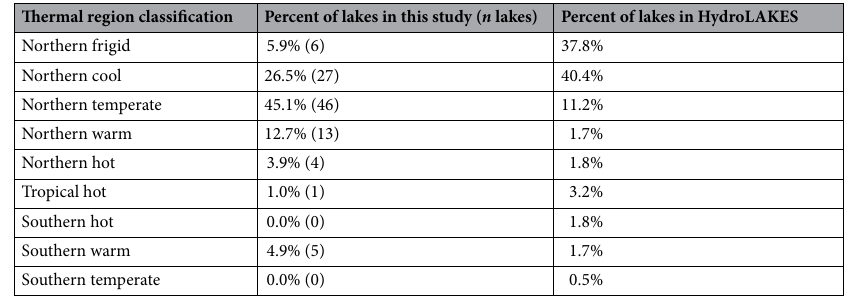
Table 2. Classification of lake thermal regions in this study compared to HydroLAKES database. Classification of thermal region 30 for the lakes in this dataset ( n = 102), compared to the percentage of lakes in each from the globally-expansive HydroLAKES database ( n = 1,427,148).